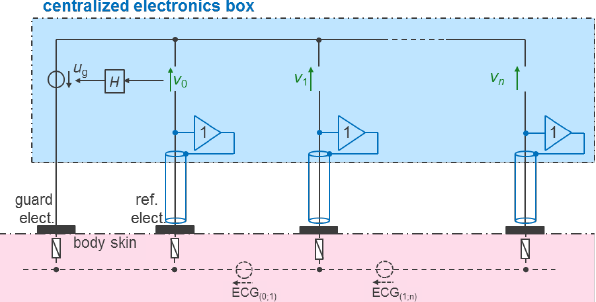
Figure 1. Classical architecture for measuring multilead